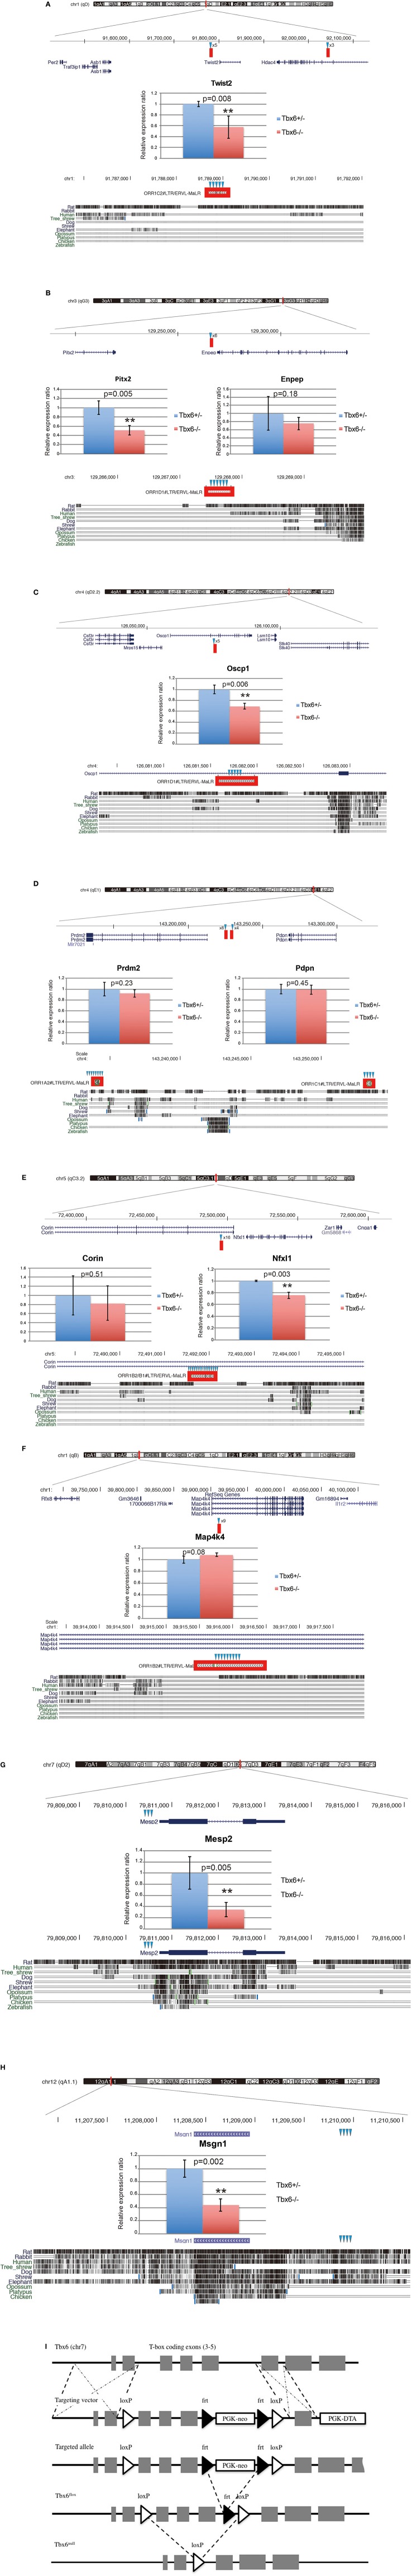
ORR1 family of ERVs function as enhancers by Tbx6-binding. Positions of LTRs including potential Tbx6 binding sites (red bars) are indicated in the upper side of each panel (A–F). Relative expression levels were determined by quantitative RT-PCR of the Tbx6-binding-LTRs adjacent genes Twist2
(A), Pitx2
(B), Enpep
(B), Oscp1
(C), Prdm2
(D), Pdpn
(D), Nfxl1
(E), and Map4k4
(F) and the previously reported positive control genes Mesp2
(G) and Msgn1
(H) in Tbx6 (+/−) (control: blue bars) and Tbx6 (−/−) (Tbx6 KO: red bars) embryos at 8.0 dpc. The relative expression ratios are normalized to the housekeeping gene β-actin. The details of Tbx6-binding LTRs and conservation among vertebrate species. The Tbx6-binding LTRs (red boxes) are also conserved in rats (bottom of A–C); however, another three are not conserved in other rodents (bottom of D–F). Tbx6-binding motifs are indicated by blue triangles. Schematic description of Tbx6 conditional KO mouse was shown in (I).